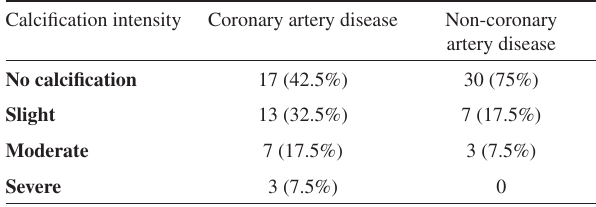
Table 2 – Analysis of the intensity of calcifications seen on mammograms according to the groups Calcification intensity